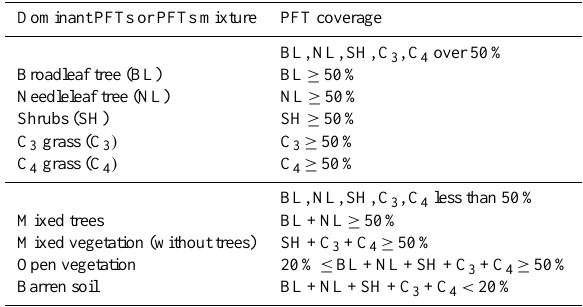
Table 2a. Distribution of dominant PFTs, which is based on the percentage of PFT coverage for the UVic ESCM results